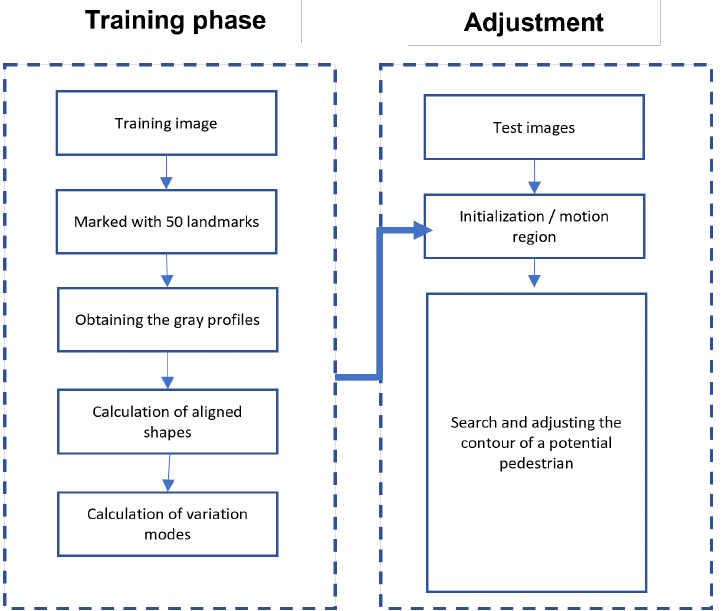
Figure 4. The tweaking of the model was carried out in two phases: training and adjustment. ASM consists of two main stages: (a) training or generation of the point distribution model (PDM) and (b) an adjustment stage. The PDM is trained on a set of annotated images; a perpendicular gray-level image model or a gradient profile is extracted for each PDM landmark, usually trained with the same set of annotated images called the training set. In each image of the training set, several reference points (landmarks) are annotated (manually) along the contour of the object of interest, as illustrated in Figure 5, where an image with 50 landmarks can be